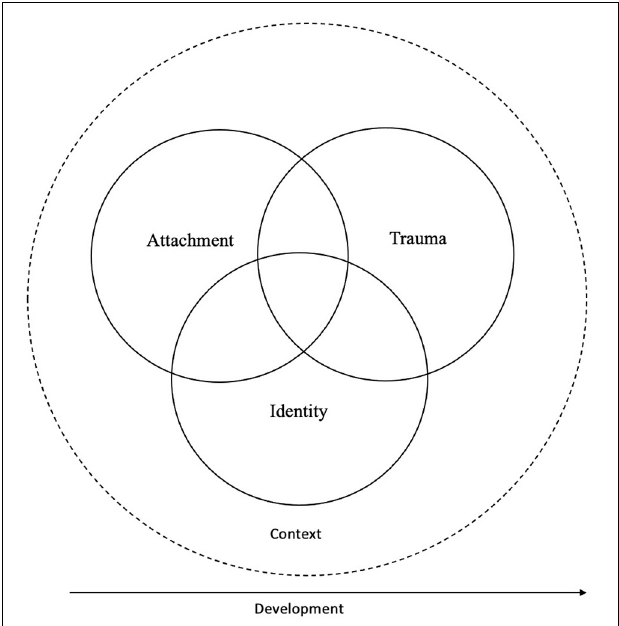
FIGURE 1 | Integration of identity, trauma and attachment in grief